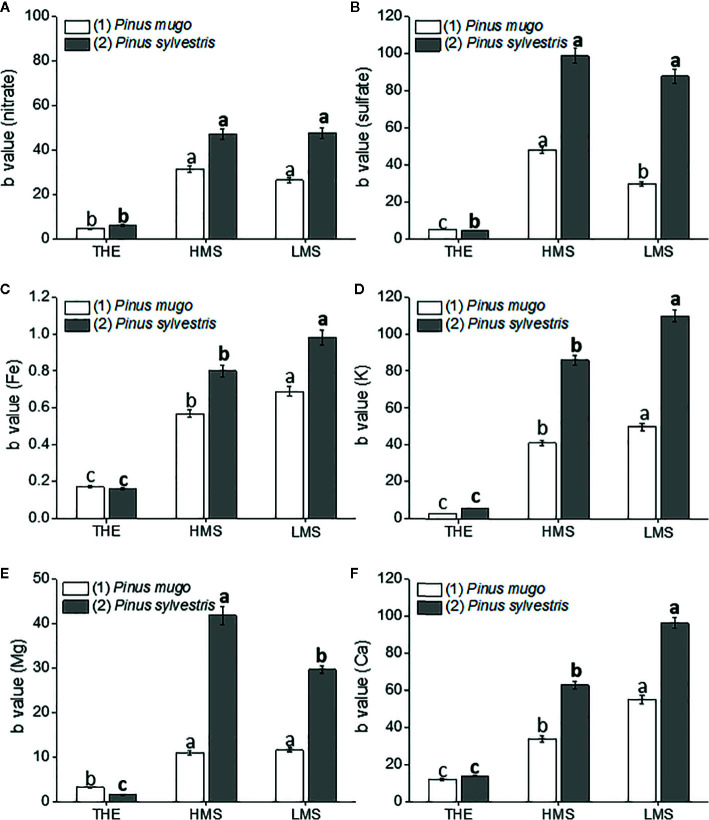
Root nutrient [nitrate (A), sulfate (B), Fe (C), K (D), Mg (E), Ca (F)] content of garlic plantlets grown in hydroponics and treated for 48 h with total humic extracts (THE) and size-fractionated HS (high molecular size, HMS and low molecular size, LMS) extracted from soil (1) (with Pinus mugo cover) and (2) (with Pinus sylvestris cover). The b values of the regression curve in the range 0 –1mg C L−1 are reported. Different letters represent significant differences at p < 0.05 (n = 5). Letters not in bold compare HS from soil (1), letters in bold compare HS from soil (2).